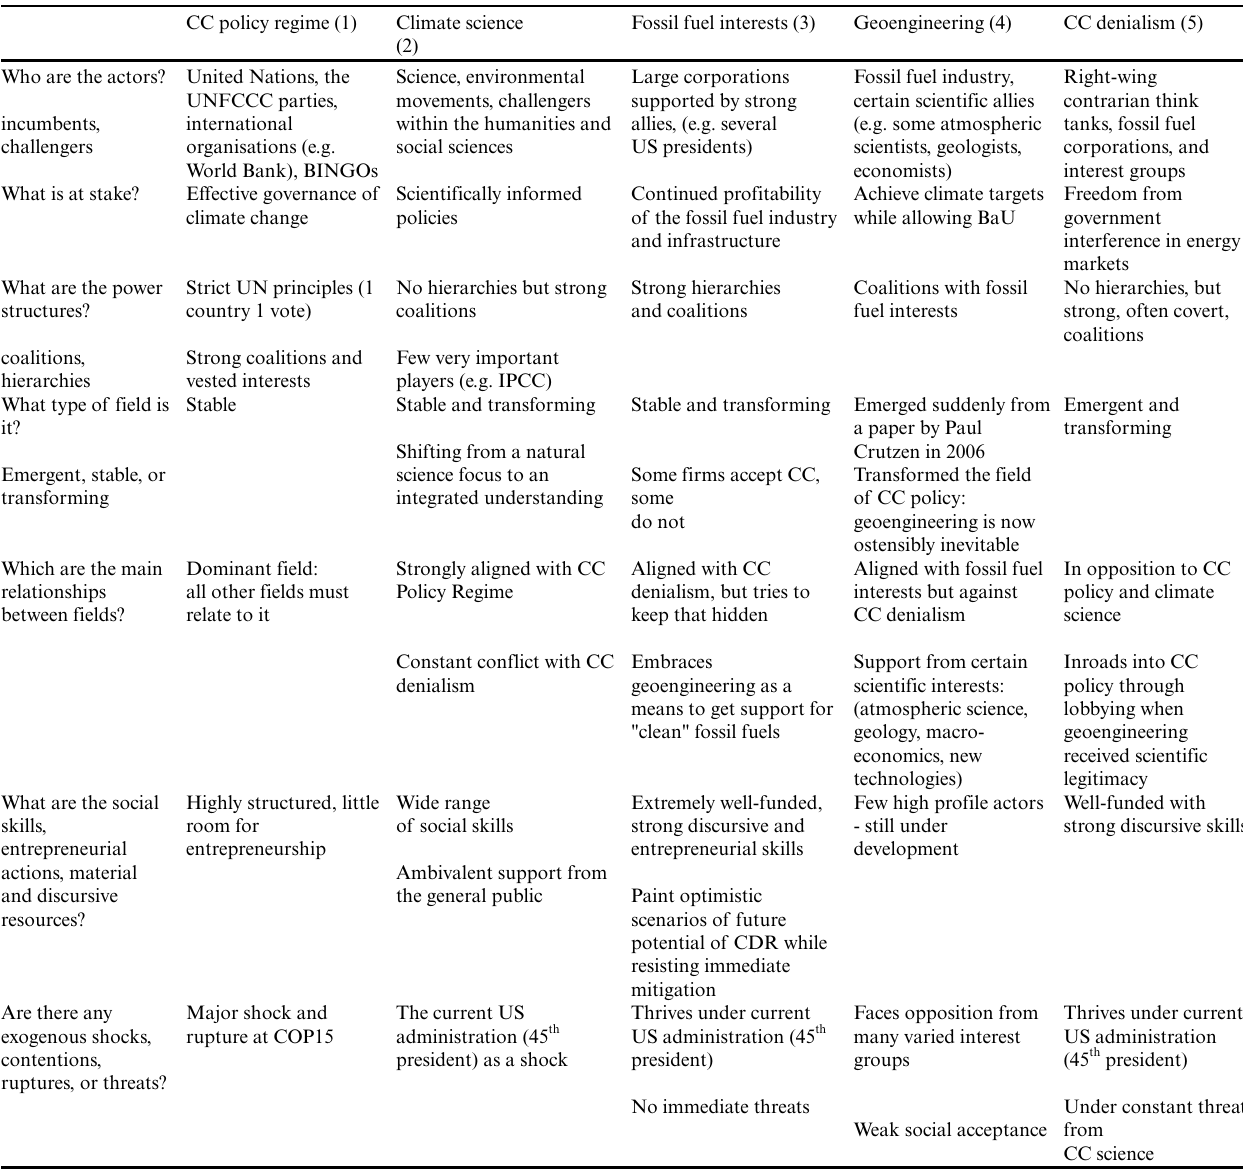
Table 1 . Summary of strategic action fields in the case of geoengineering (numbers refer to Figure